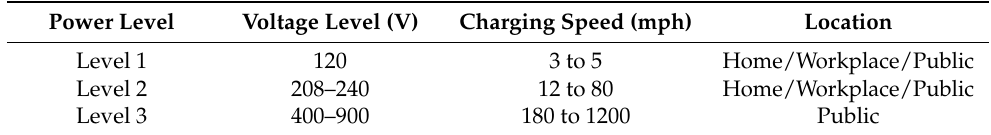
Table 2. Charging power